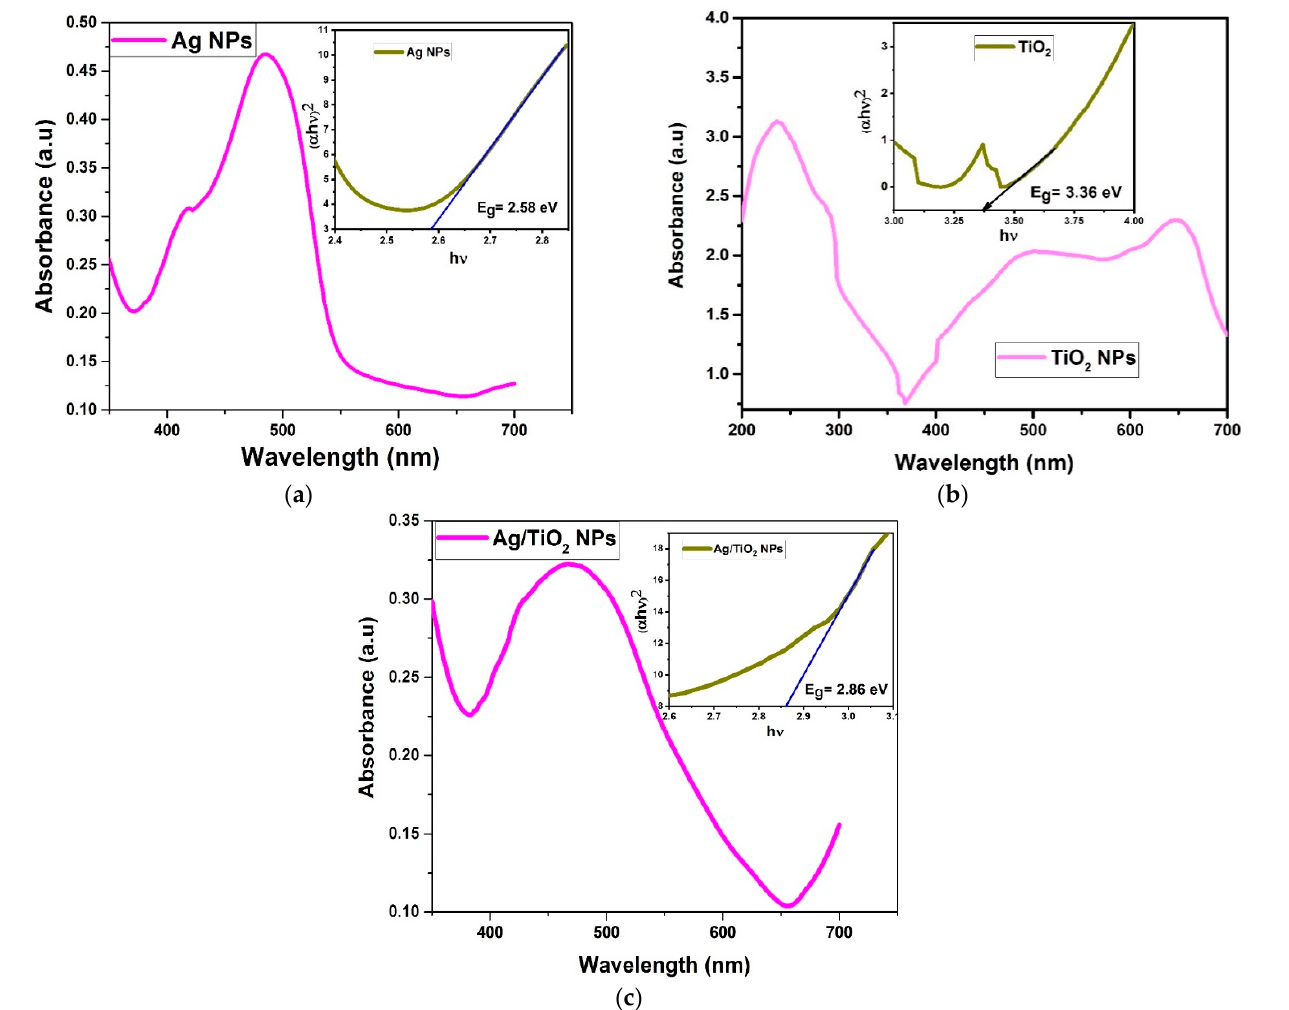
Figure 5. UV absorption spectra and band gap energy measurements of pure ( a ) AgNPs, ( b ) pure TiO 2 NPs and ( c ) Ag/TiO 2 nanocomposite.